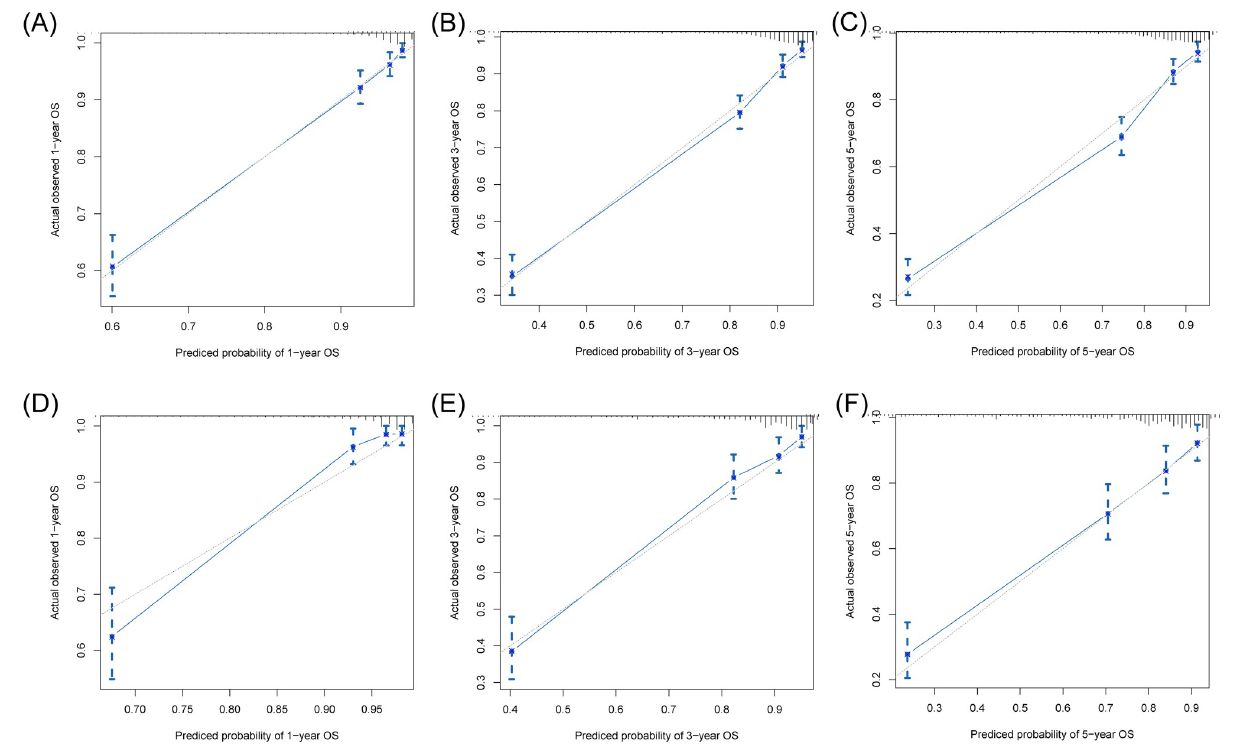
Fig 3. Calibration curves of the NomogramB using the training cohort for predicting the 1- (A), 3- (B), and 5- (C) year OS rates of patients with NF- pNET. Calibration curves of the NomogramB using the validation cohort for predicting the 1- (D), 3- (E), and 5- (F) year OS rates of patients with NF-